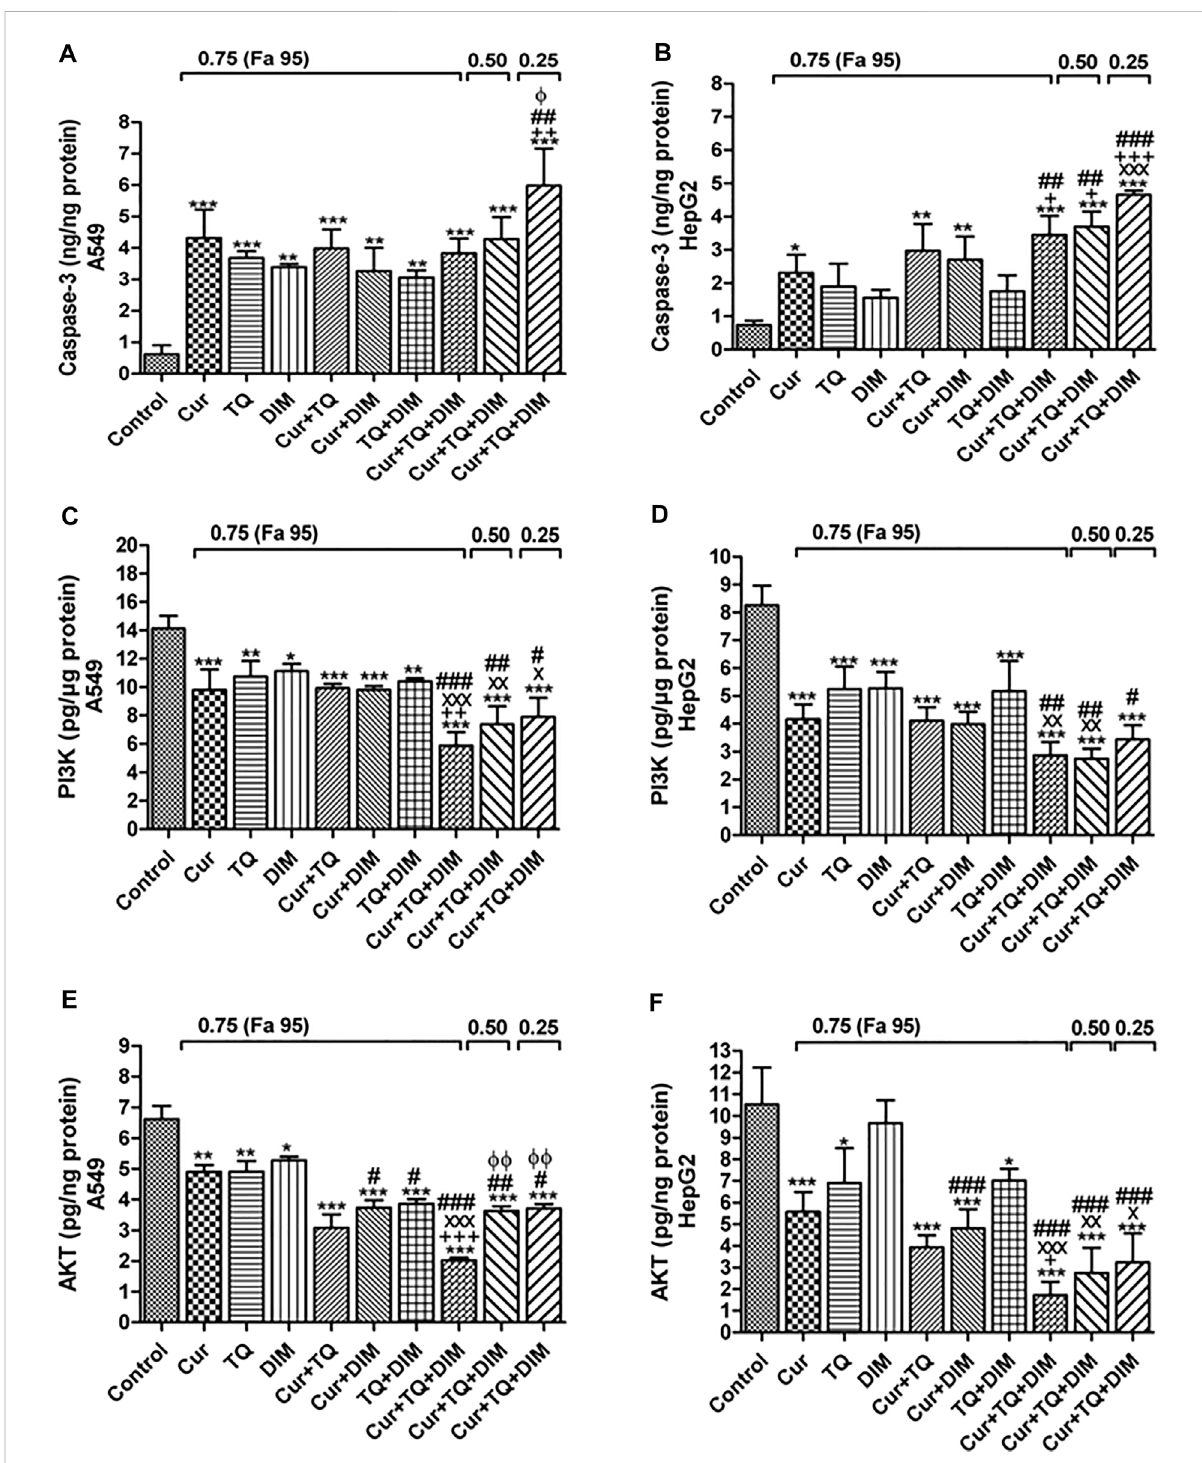
FIGURE 9 Enzyme-linked immunosorbent (ELISA) assay. (A) Caspase-3 (ng/ng protein) (C) phosphatidylinositol 3-kinase (PI3K, pg/µg protein), and (E) Protein kinase B (AKT, pg/ng protein) levels in control, A549-treated with 0.75 (Fa 95) of Cur, TQ, DIM, Cur + TQ, Cur + DIM, TQ + DIM, and Cur + TQ + DIM, A549-treated with 0.50 (Fa 95) of Cur + TQ + DIM, and A549-treated with 0.25 (Fa 95) of Cur + TQ + DIM. (B) Caspase-3 (ng/ng protein) (D) PI3K (pg/µg protein), and (F) AKT (pg/ng protein) levels in control, HepG2-treated with 0.75 (Fa 95) of Cur, TQ, DIM, Cur + TQ, Cur + DIM, TQ + DIM, and Cur + TQ + DIM, HepG2-treated with 0.50 (Fa 95) of Cur + TQ + DIM, and HepG2-treated with 0.25 (Fa 95) of Cur + TQ + DIM. The data were analyzed with one-way ANOVA followed by Tukey ’ s multiple comparison test. Error bars represent mean ± SD. * p < 0.05, ** p < 0.01, and *** p < 0.001 vs. control. x P < 0.05, xx P < 0.01, and xxx P < 0.001 vs. Cur. + p < 0.05, ++ p < 0.01, and +++ p < 0.001 vs. TQ. # p < 0.05, ## p < 0.01, and ### p < 0.001 vs.